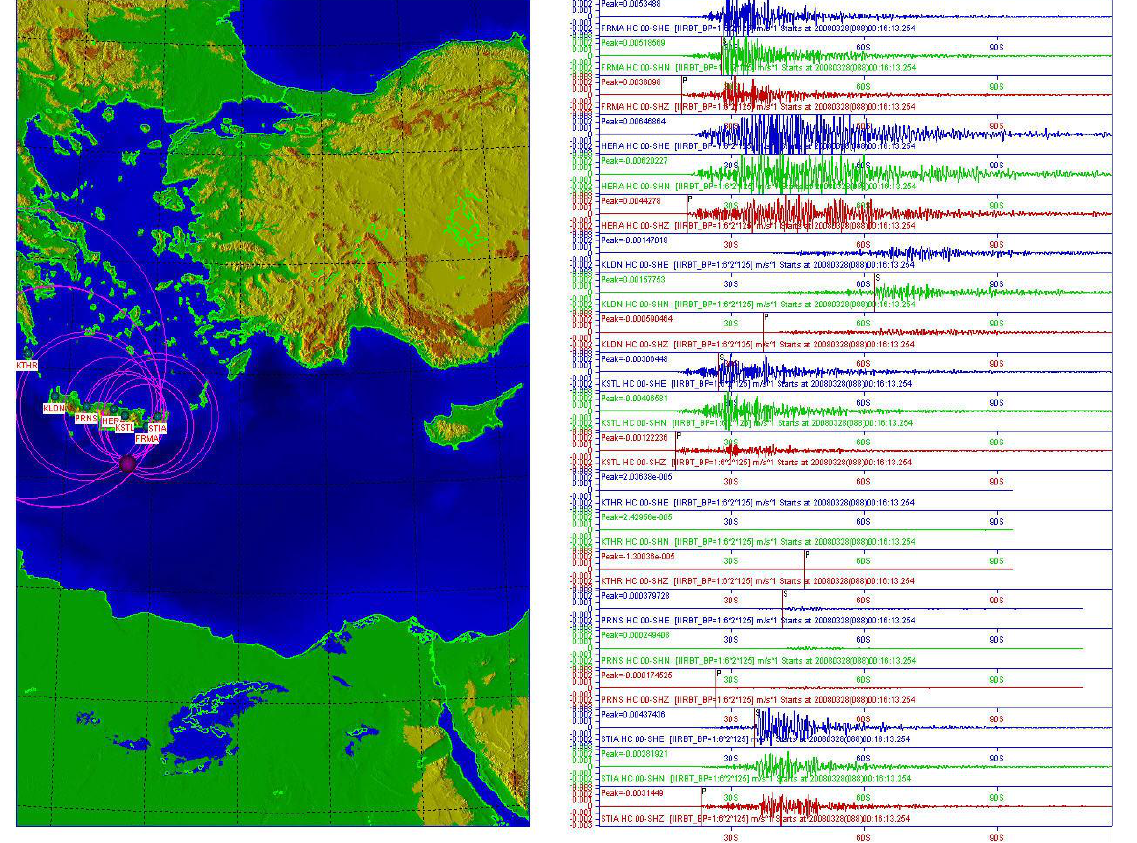
Fig. 7. A typical real example of a graphical seismic bulletin generated by HSNC for an event off coast of East Crete having M W 5.7, occurred on 28 March 2008 00:16:20UTC with location 34.87 ◦ N, 25.52 ◦ E and depth